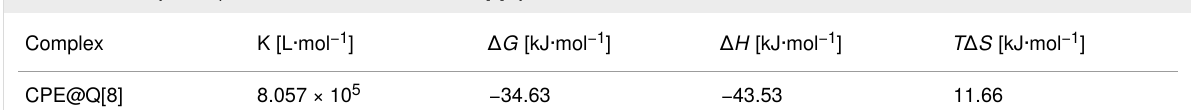
Table 1: Thermodynamic parameters related to the CPE@Q[8] system at 25 °C. Complex